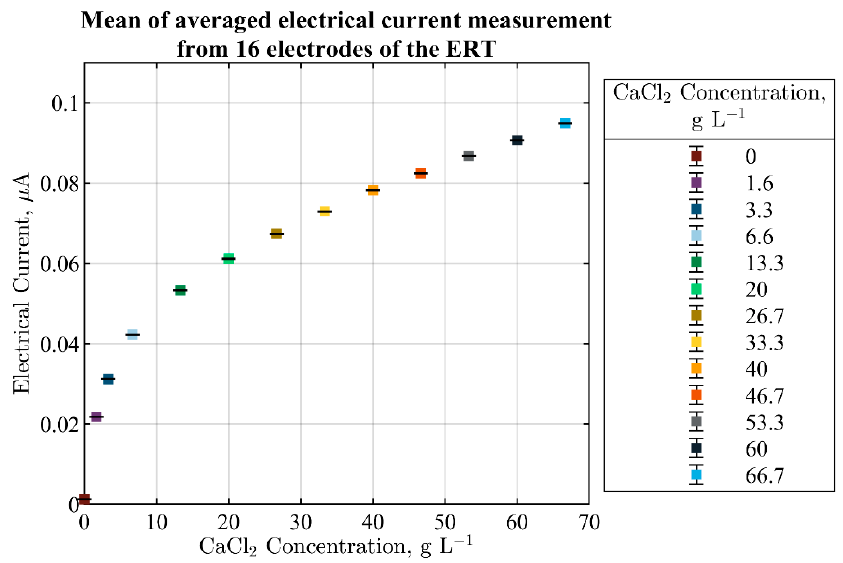
Figure 5. Mean of averaged current measurement from 16 electrodes of the ERT for quantification of the total current of the solution. Different concentrations of CaCl 2 solutions are used for a 1-min measurement. Solutions are stable with no mixing.